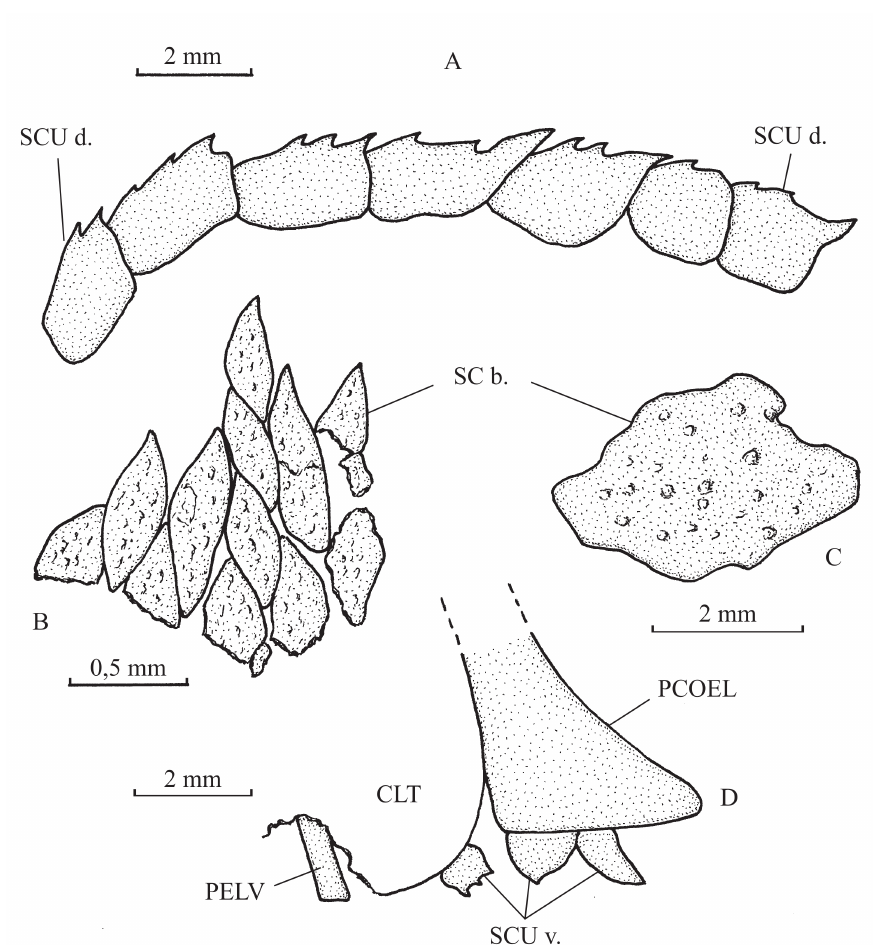
Fig. 16. Joinvillichthys kriweti gen. et sp. nov. Holotype, CLC S-137. A . Dorsal ridge scutes. B . Anterior flake-like body scales. C . Posterior scute-like body scale. D . Ventral keel